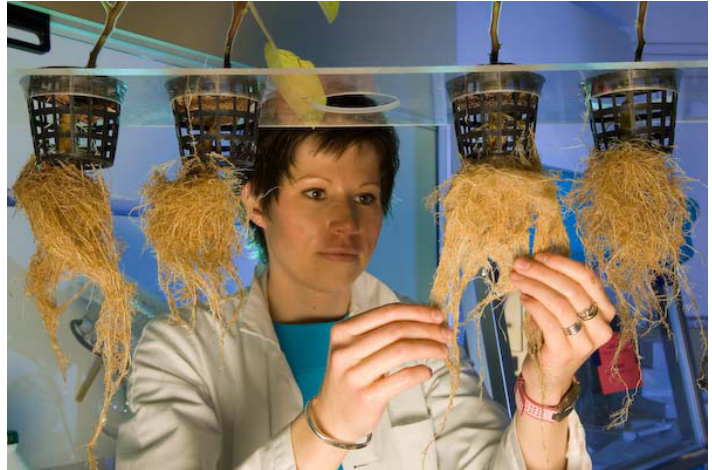
Figure 3. Plant milking technology. (PAT plant milking © . Photograph: Philippe